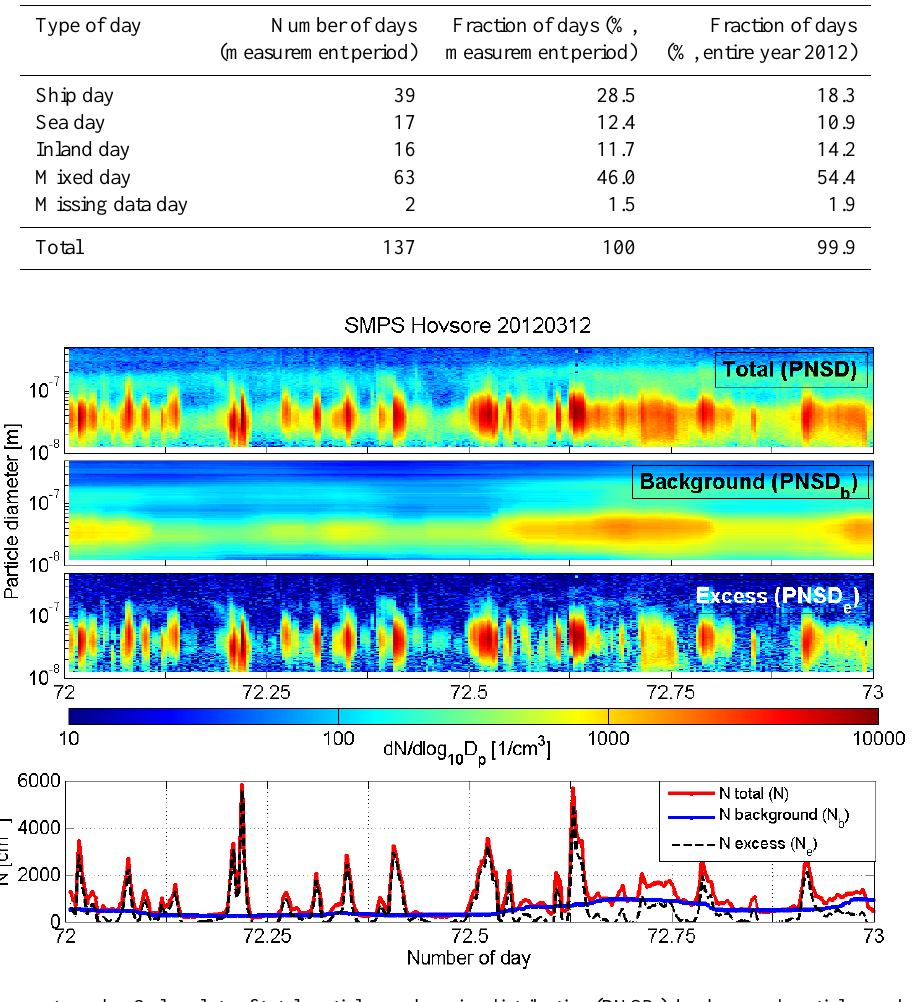
Figure 5. Three uppermost graphs: Color plots of total particle number size distribution (PNSD), background particle number size distribution (PNSD b ) and excess particle number size distribution (PNSD e ) as functions of time during 12 March 2012. All three graphs have the same color axis. Bottom graph: The corresponding number concentrations N , N b and N e as function of